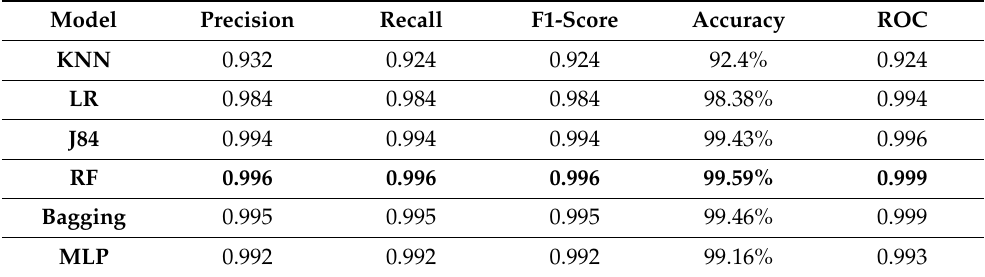
Table 6. Binary experiment results before feature